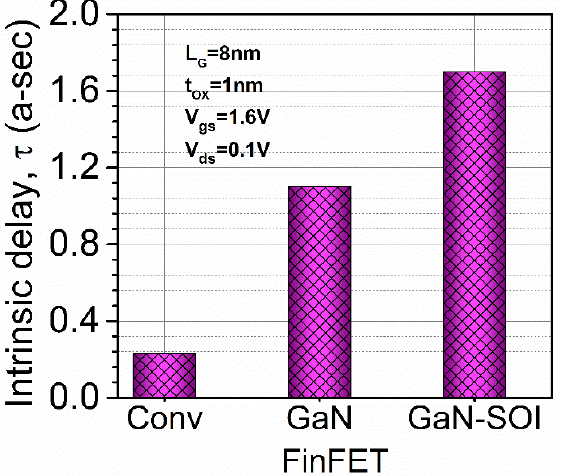
Figure 8. Intrinsic delay for Conv. FinFET and GaN-SOI-FinFET.